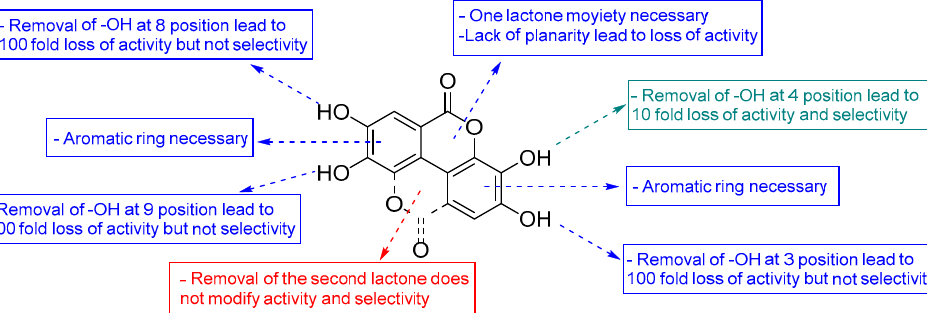
Figure 8. SAR study on EA and its derivatives as PKL inhibitors.